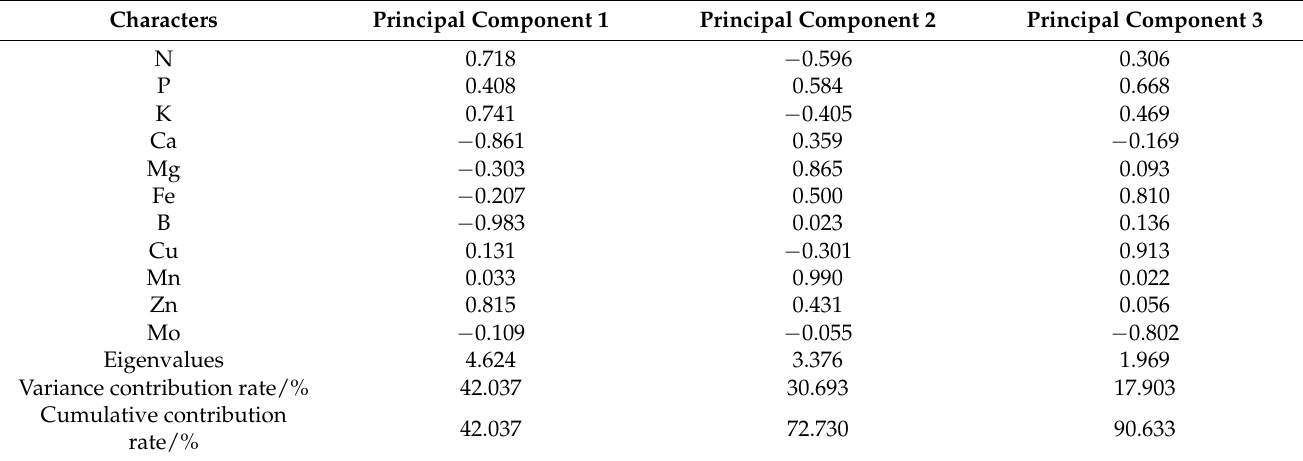
Table 5. Analysis of nutrient element factors of diseased leaves.